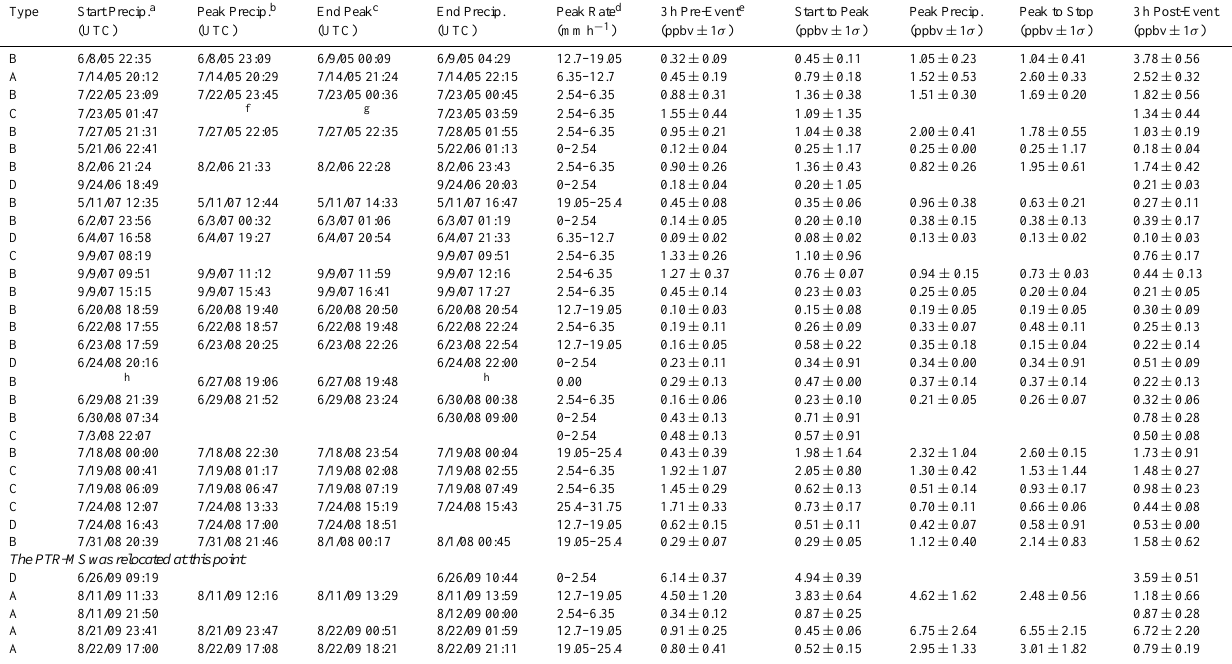
Table 1. Storm events at Thompson Farm, identified by radar data. All times are given in UTC. (Local Time=UTC − 4h). Type is the classification assigned, as described in the text (Sect.